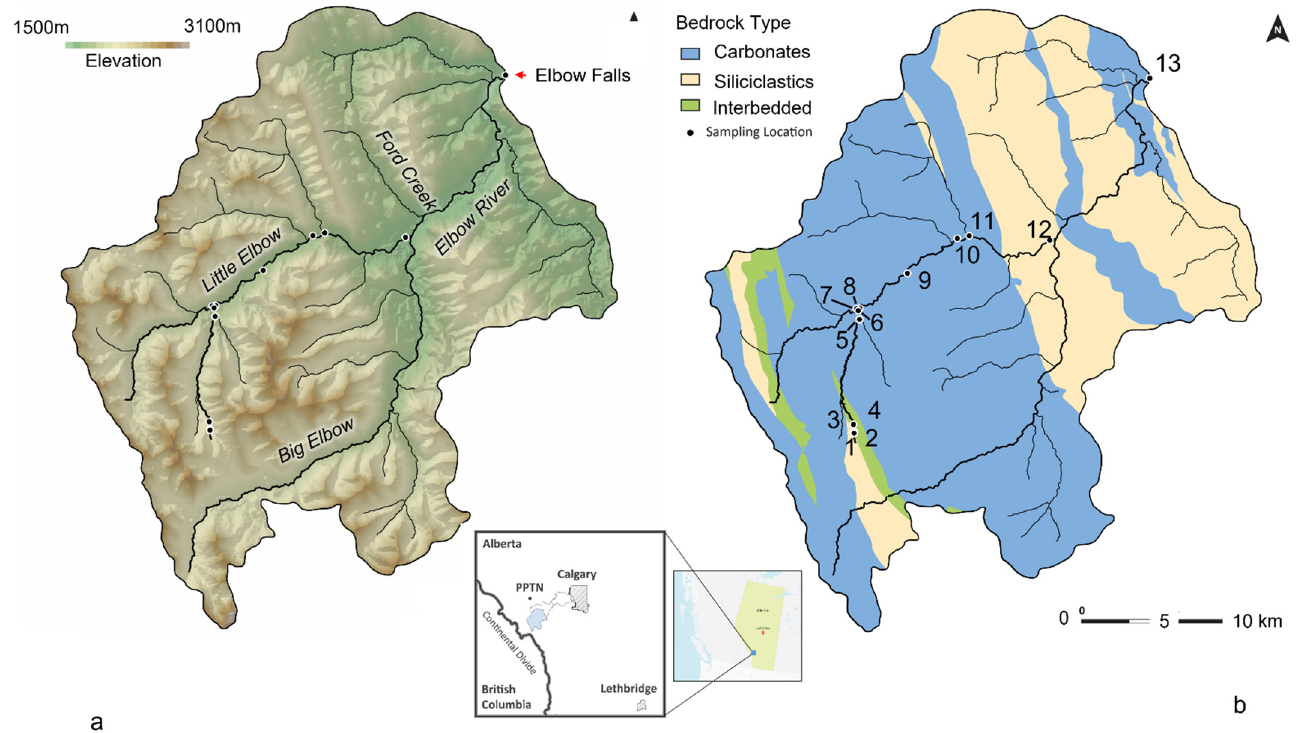
Figure 1. Upper Elbow watershed. ( a ) Linear relief shading. Sample collection points are indicated with black circles. ( b ) Watershed bedrock types. Most of the Upper Elbow watershed (including the Little Elbow where sampling was conducted) is carbonate rock (~73%), with siliciclastics upper extremities (~27%) and small areas of carbonate and siliciclastic interbedded layering. Inset shows upper (blue), middle and lower Elbow watersheds in relation to Calgary, Alberta [40]. Numbers indicate sampling locations (named in Table